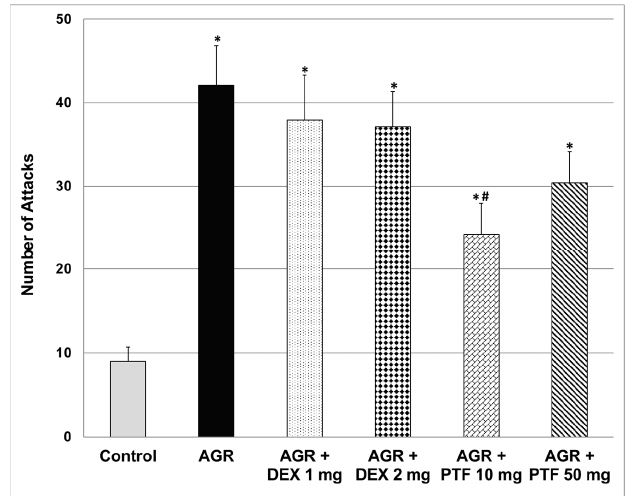
Figure 3. Effects of DEX and PTF on aggressive behavior. Values are means ± SEM of 11–12 rats in each group. One-way ANOVA test: F = 8.89, p < 0.0001; t -test: * p < 0.05 vs. control, # p < 0.05 vs. aggressive rats. AGR—aggressive, DEX—dexamethasone, PTF—pentoxifylline, RIAT—resident-in- truder aggression test.